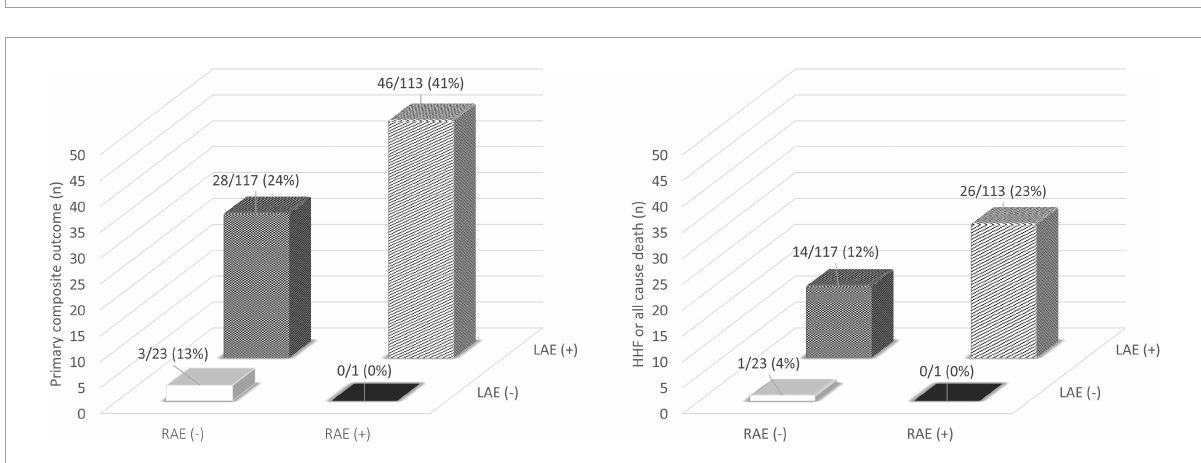
FIGURE5 Incidence of adverse clinical outcome classified by atrial enlargement. HHF, hospitalization for heart failure; LAE, left atrial enlargement; RAE, right atrial